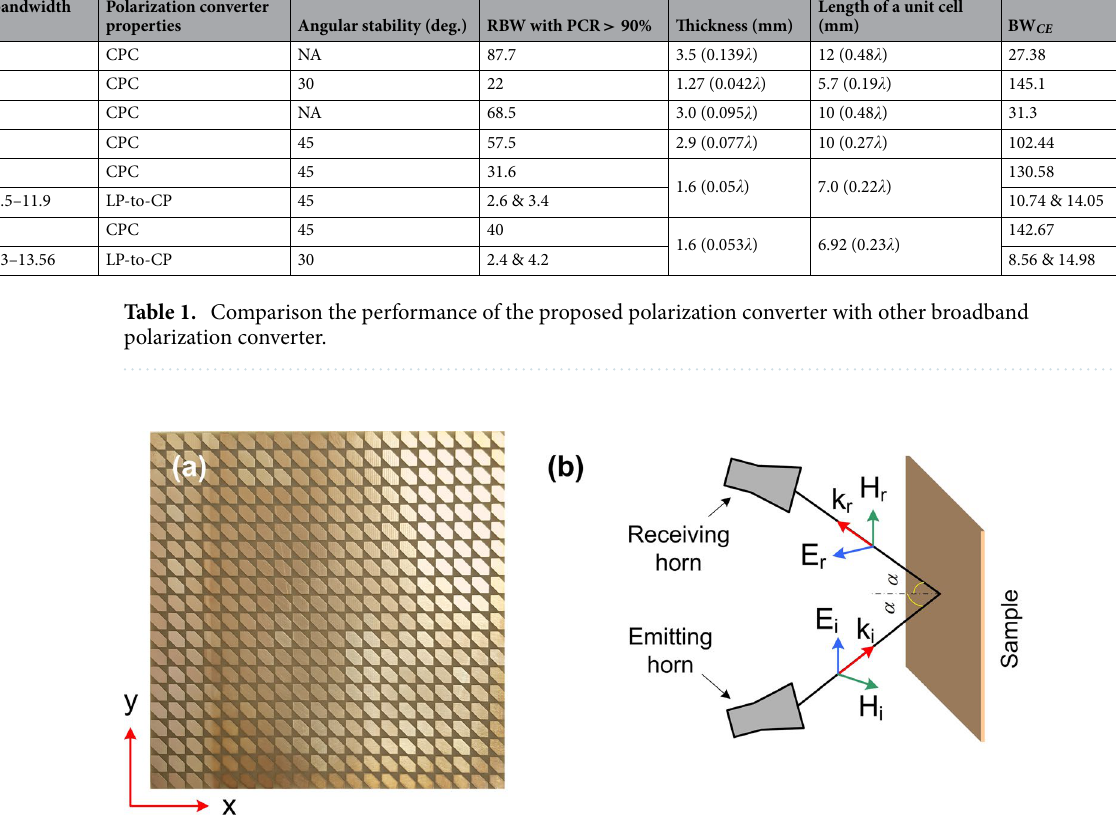
Figure 11. ( a ) Photograph of the fabricated sample and ( b ) schematic illustration of the measurement